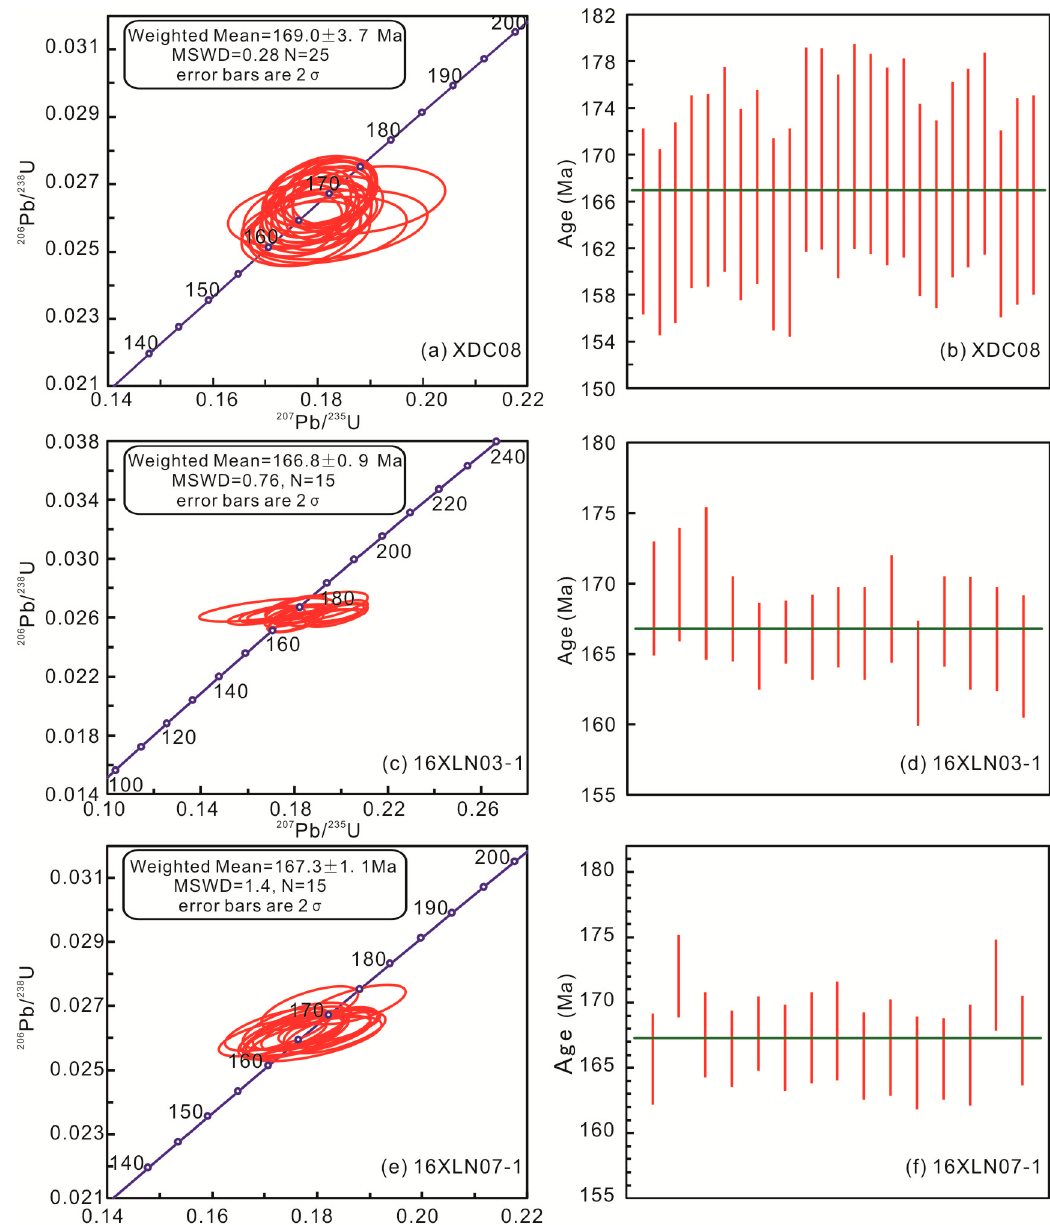
Figure 7. Zircon U–Pb concordia curves and average plots of the analyzed zircon grains separated from the investigated rocks of the Dongco and Lanong ophiolites. ( a ) and ( b ) Sample XDC08: Anorthosite, Dongco ophiolite; ( c ) and ( d ) sample 16XLN03-1: Anorthosite, Lanong ophiolite; ( e) and ( f ) sample 16XLN07-1: Gabbro, Lanong ophiolite.